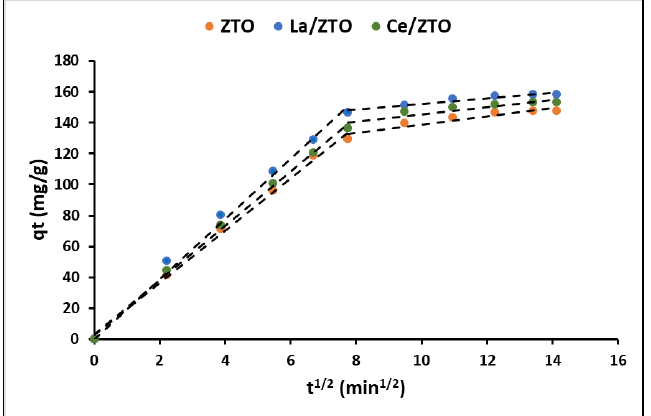
Figure 8. Intraparticle diffusion plots for cyanide removal by